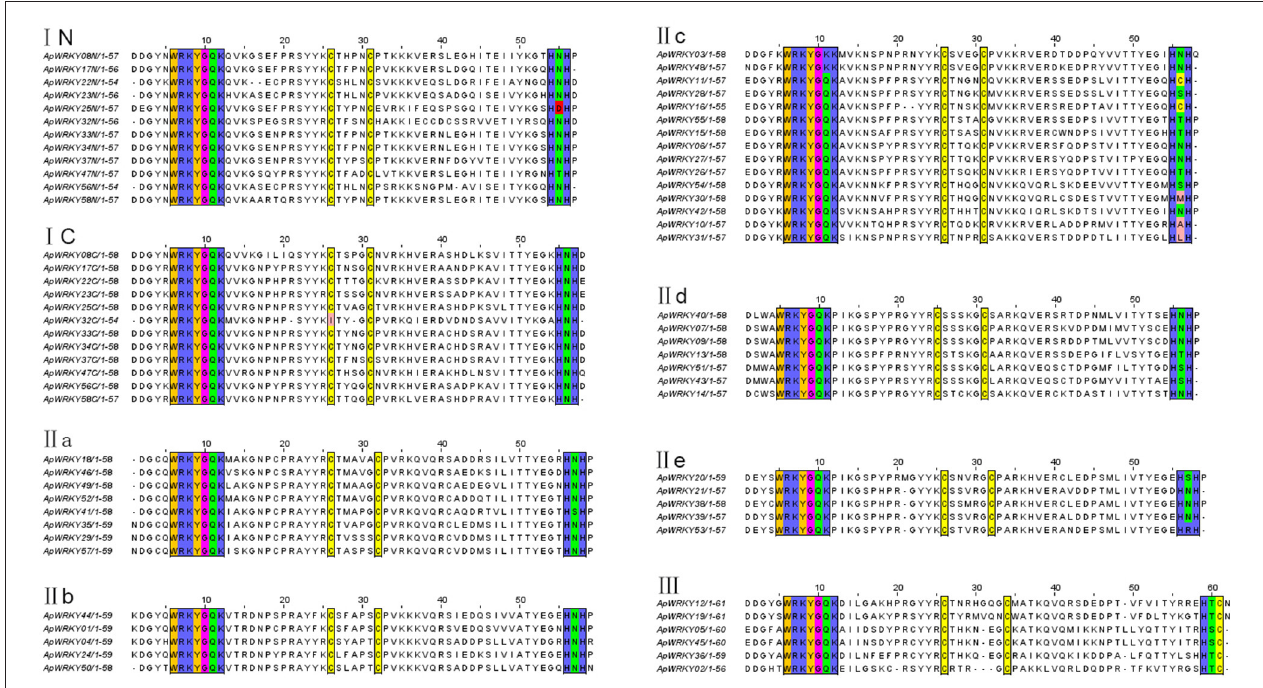
FIGURE 2 | Comparison of deduced amino acid sequences of the WRKY domains from ApWRKYs. Black box indicates conserved WRKY amino acids and zinc-finger